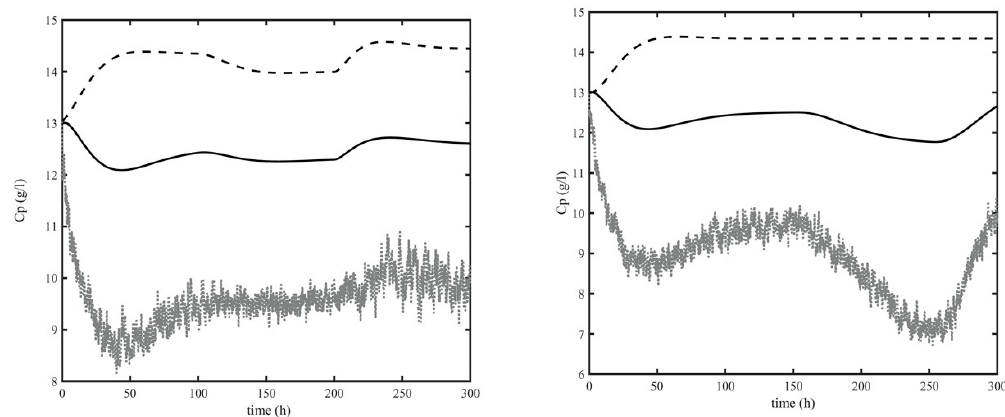
Figure 4. Dynamic response of ethanol concentration calculated with the virtual plant (continuous line), open-loop model (dashed line) and GO (dotted grey line) for structure φ 2 along trajectory T1 ( left panel) and T2 ( right panel).